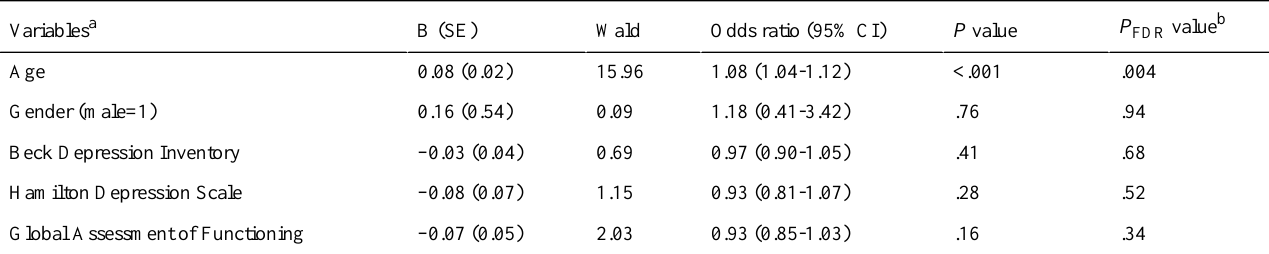
Table 1. Ordinal logistic regression analysis results predicting the effects of age, gender, and symptom severity on support required during data entry.